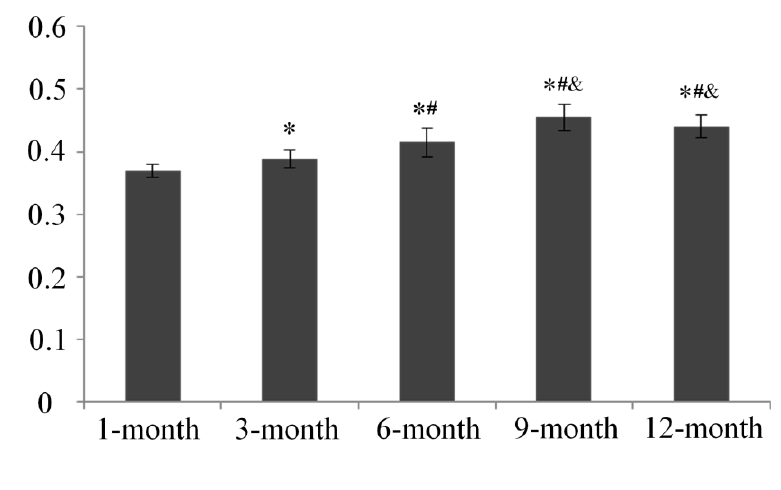
Figure 11. Bone Mineral Density (BMD) of medial proximal tibia in each age group. * p < 0.05, compared with 1-month group; # p < 0.05, compared with 3-month group; & p < 0.05, compared with 6-month